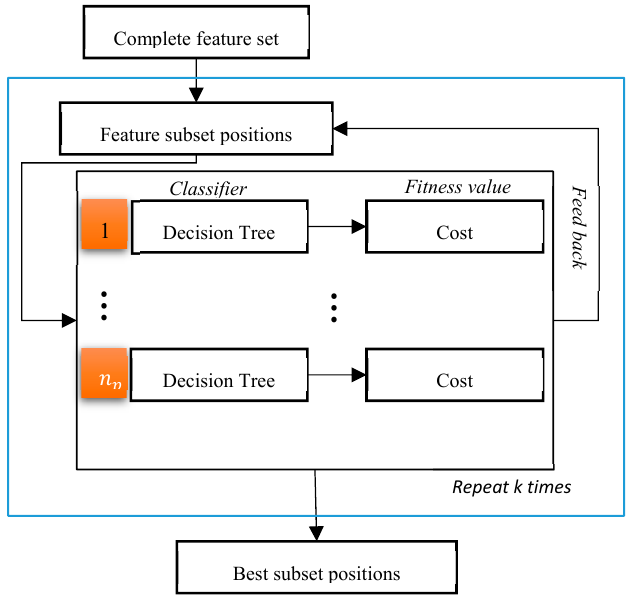
Figure 6. Graphical illustration of the filterbank particle swarm optimization (FBPSO) algorithm, where n p is a number of particles for PSO.